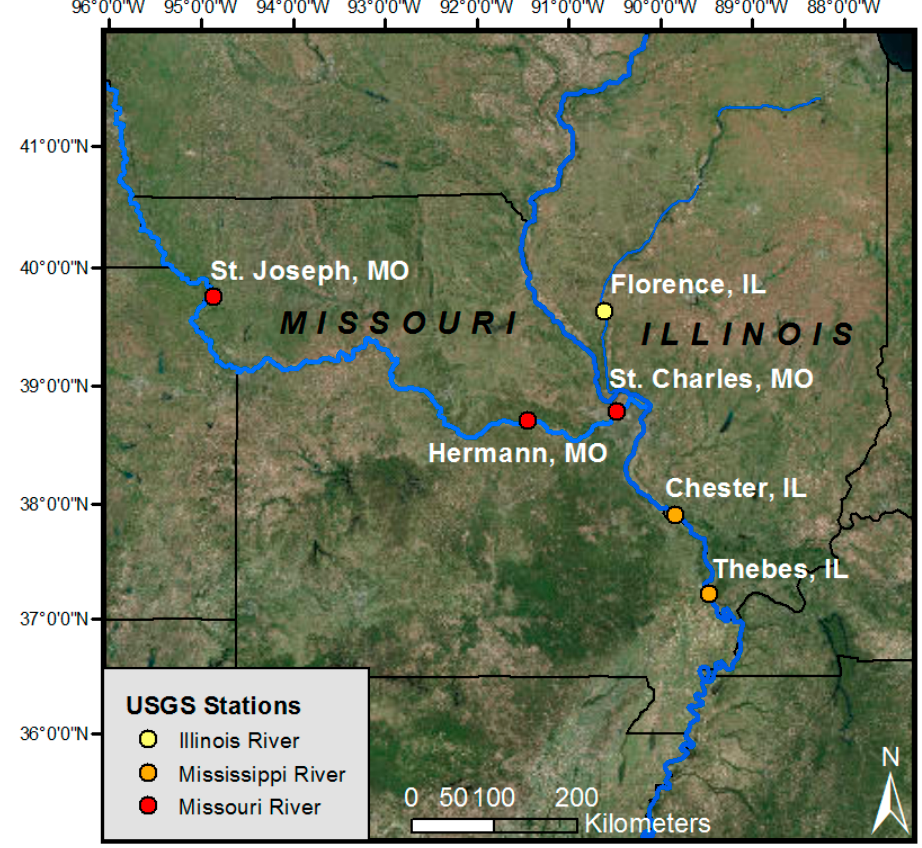
Figure 1. Map of the study area detailing the six United States Geological Survey (USGS) sampling stations color coded by the major rivers they are located along.